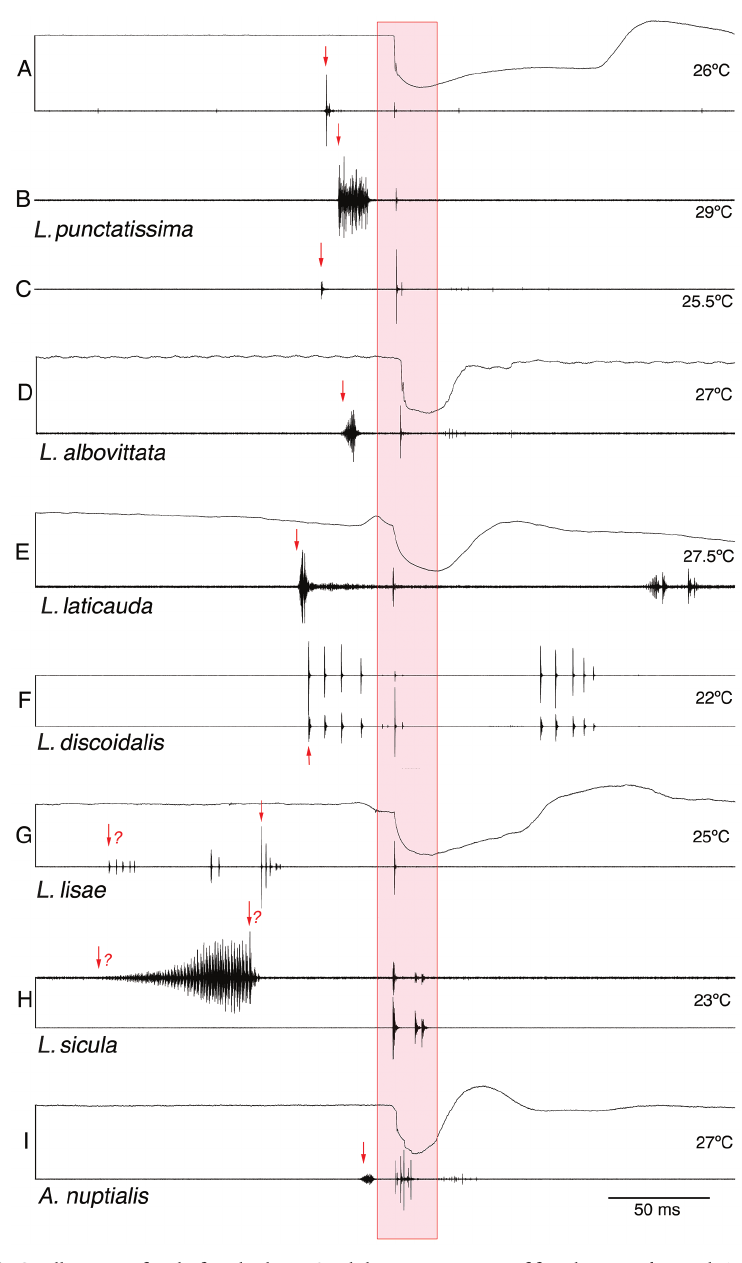
Figure 2. Oscillograms of male-female-duets. Stridulatory movement of female Leptophyes and Andreiniimon together with male-female duet (sound A, D, E, G, I ) or male-female duet, sound only ( B, C, F, H ). Oscil- lograms of stridulatory movement and song [synchronous registration of left tegmen movement and sound (upper line: upward deflection represents opening, downward closing; lower line: sound)]. A–C female reac- tion to model of male song D female reaction to heterospecific male song (see text) E–I female reaction to con- specific male song. Female responses in box highlighted in red, proposed trigger point marked with red